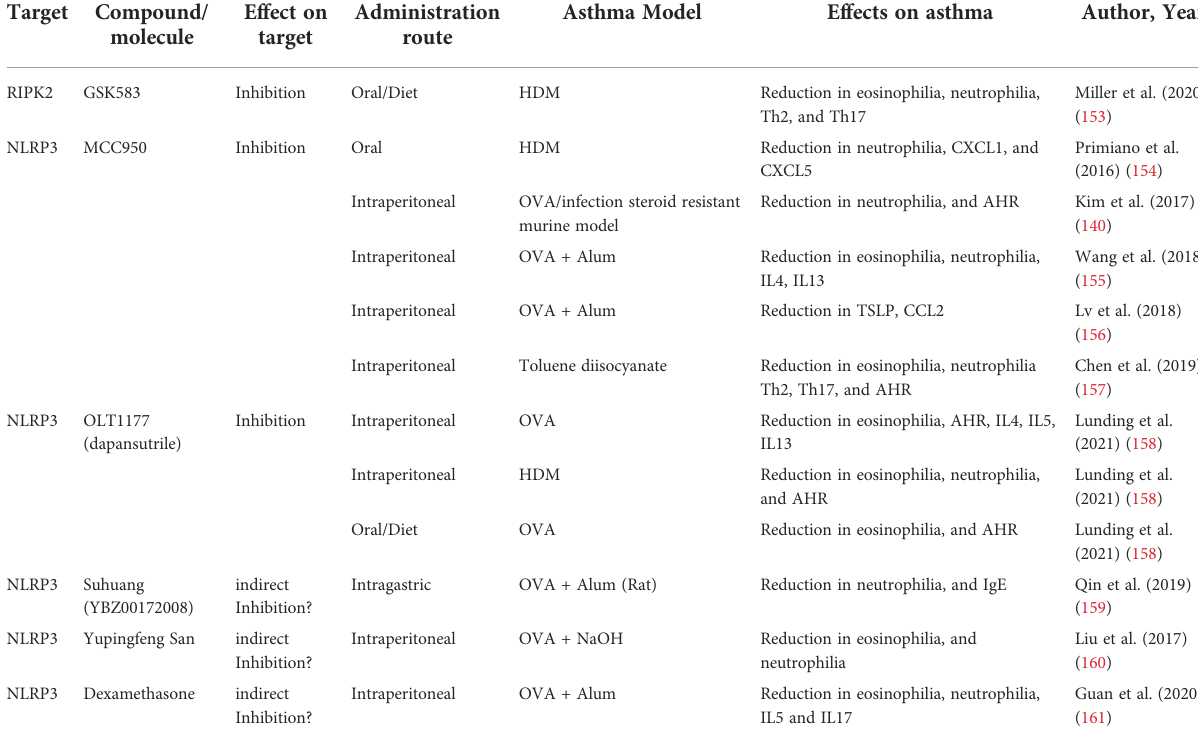
TABLE 2 Compounds targeting the NLR pathway and their effects in asthma